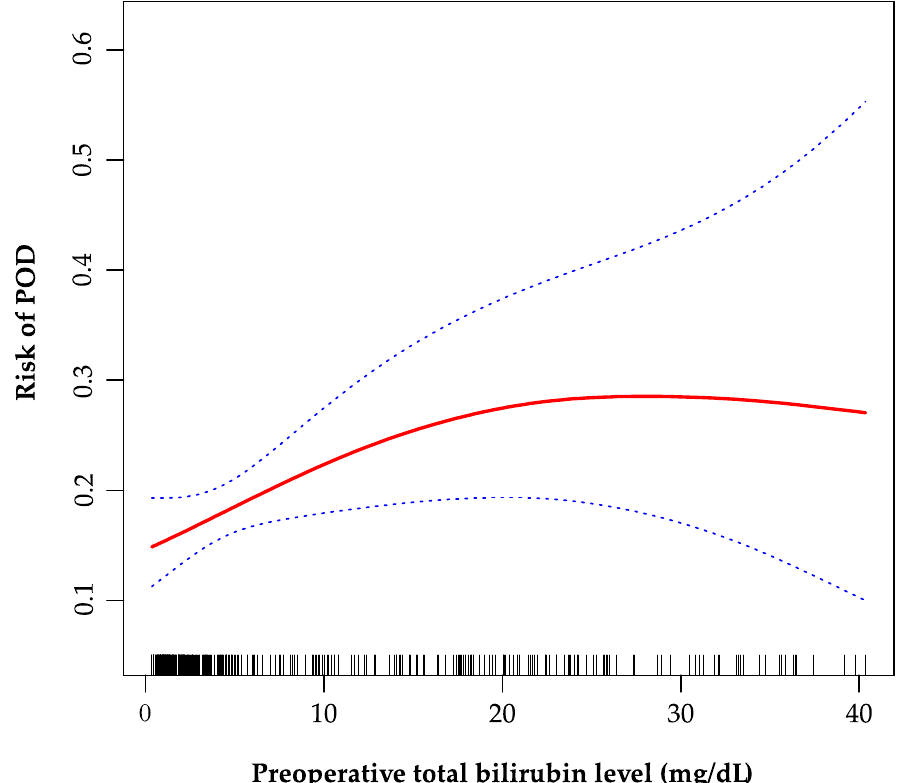
Figure 2. The non-linear relationship between preoperative total bilirubin and POD. A non-linear relationship between them was identified after adjusting for age, gender, creatinine, international normalized ratio, sodium, malignancy, encephalopathy, artificial liver support, auto-transfusion, intraoperative renal replacement therapy, and post-transplant ammonia. POD, postoperative delirium. Table 4. The results of two-piecewise regression model.